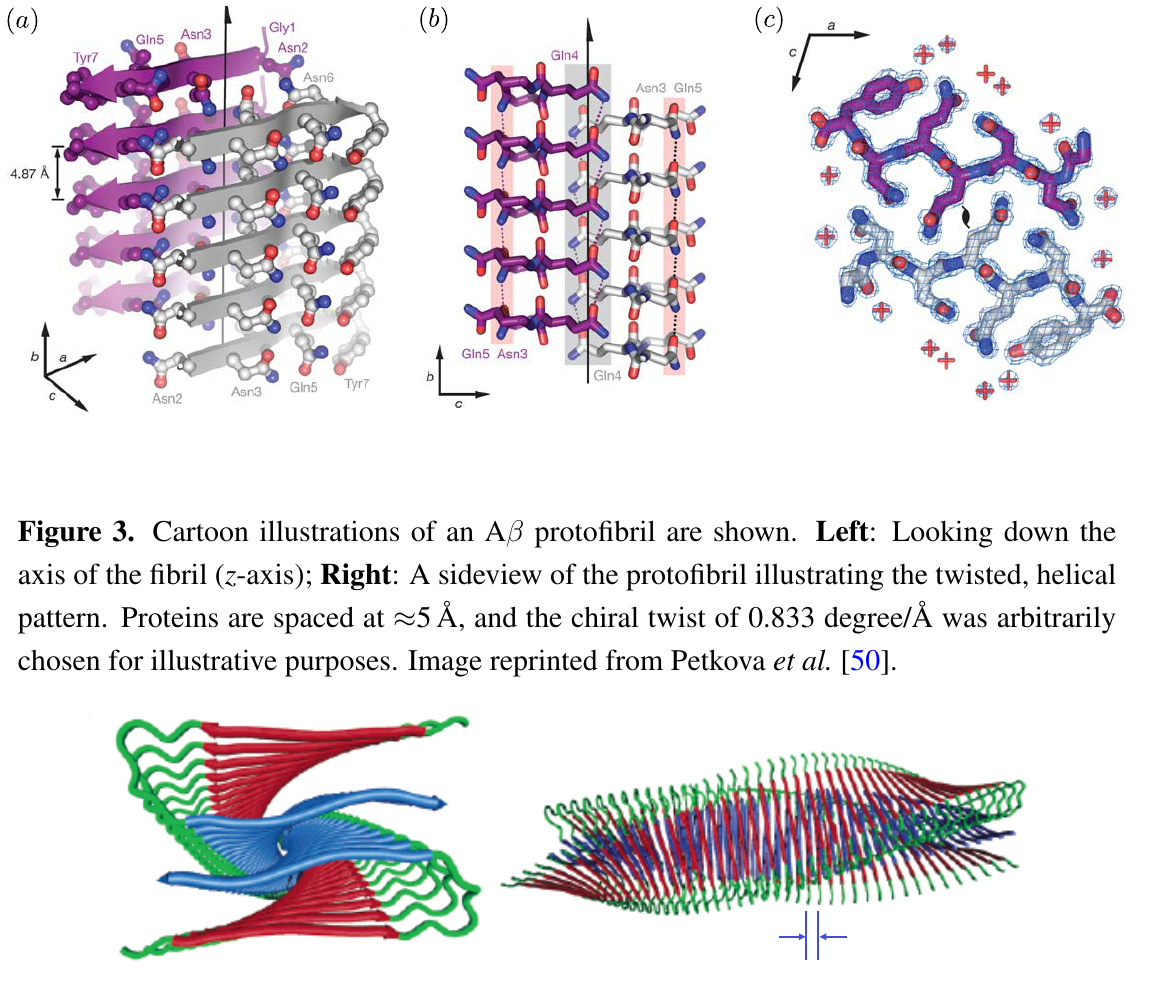
Figure 2. In both ( a ) and ( b ), the illustrated cross- β structure is the sequence segment GNNQQNY from the prion Sup35. Carbon atoms are purple or grey/white, oxygen atoms are red, and nitrogen atoms are blue. In ( a ), cross- β structure is illustrated. Grey arrows represent the back-bone of a β -strand, and the side-chains are shown projecting from the strands. Purple arrows represent the strands residing in the back of the structure. The regions between the strands are referred to as the dry interfaces, whereas just outside of strands are wet interfaces. The fibril axis is indicated by an arrow running through the dry regions between the strands; ( b ) Side view of the fibril. The H-bonds are formed between red carboxyl groups and blue amide groups from adjacent layers; in ( c ), a top view of the fibrils shows the interdigitation of two β -sheets, referred to as the steric zipper. Within the steric zipper, water molecules are absent (a red plus sign indicates water). Both images are reprinted from Nelson et al. [48,49].